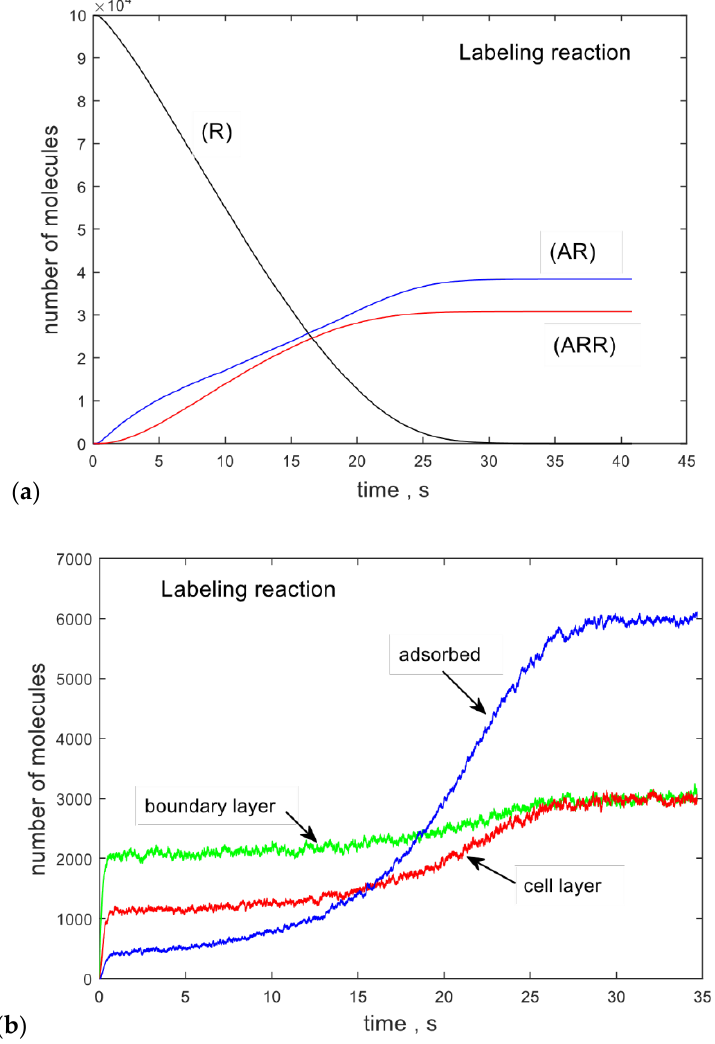
Figure 3. ( a ) The labeled traces show the time dependence of the surface-bound populations in the labeling reaction. These include (R), the surface unbound receptors, and (AR) and (ARR), the monovalent and bivalent complexes of R and A. ( b ) The labeled traces show the time dependence of the mAb populations of layers surrounding the cell and providing a path for the transport of mAbs to the surface of the cell. The layers are defined in Figure 2.